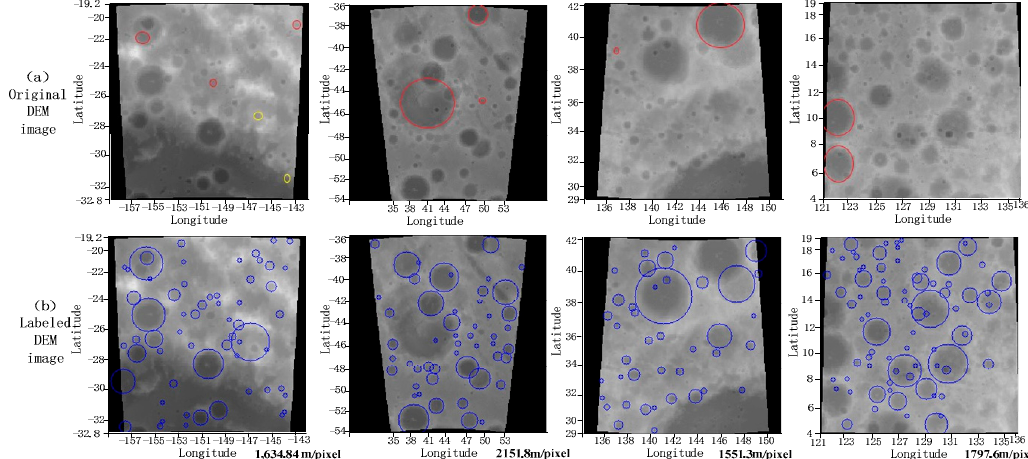
Figure 1. Original images and labeled images. ( a ) is the original image. ( b ) is the labeled image, yielding the ground-truth crater set here. The red circles in original images are the impact craters with obvious missing marks, and the yellow circles in original images are the impact craters with incorrect mark. The bottom right corner reflects the scale bars of the labeled DEM image. It means a pixel in the image corresponds to the real size.